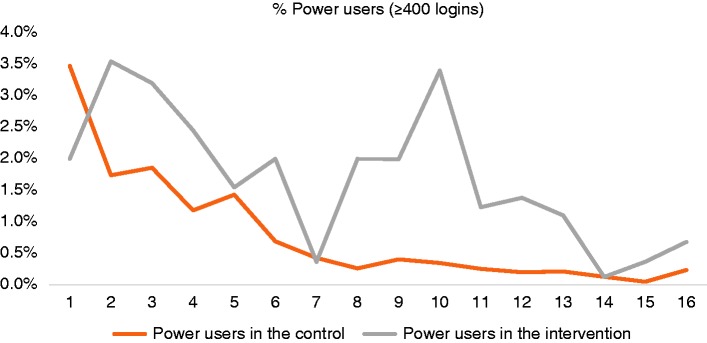
Plot of the proportion of ‘power users’ (i.e. participants who engaged
with the app ≥400 times during the study period) by week of
randomisation, split by study arm.